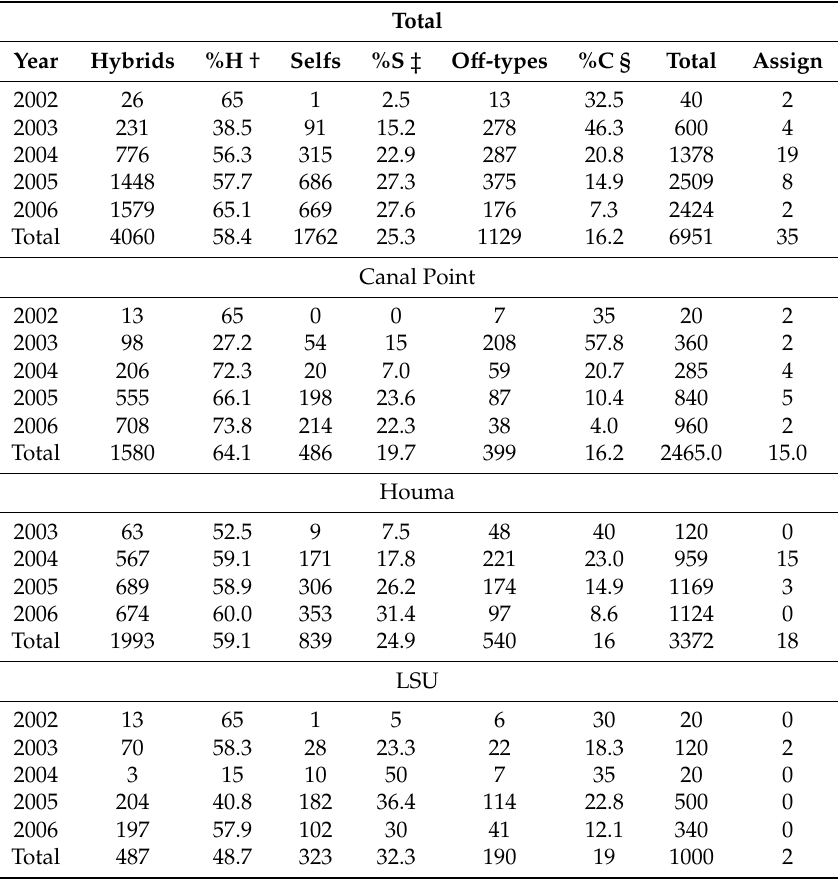
Table 3. Identification of hybrids, selfs, and o ff -types among 7200 seedlings in 2002, 2003, 2004, 2005, and 2006 and the